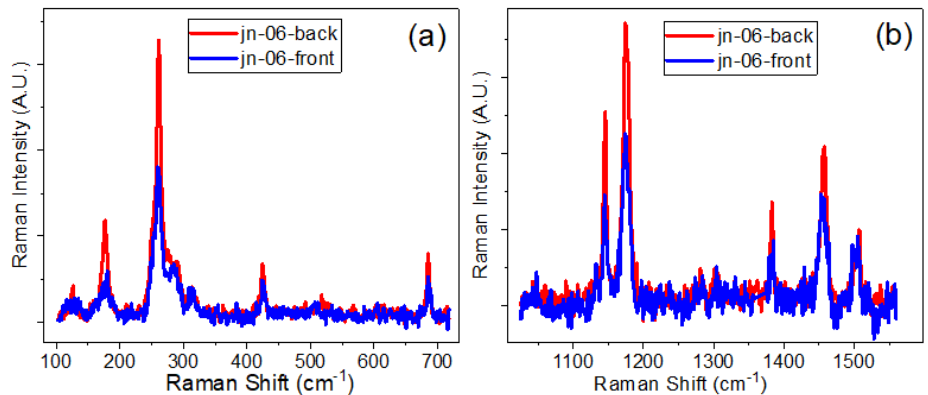
Figure 7. Raman spectra measured in different regions, ( a ) 100–750 cm − 1 and ( b ) 1000–1600 cm − 1 , for ZIF ‐ 67 ‐ 1 infiltrated into etched MCG channels, sample jn06, from the front (blue line) and from the back (red line) sides of the MCG plate.